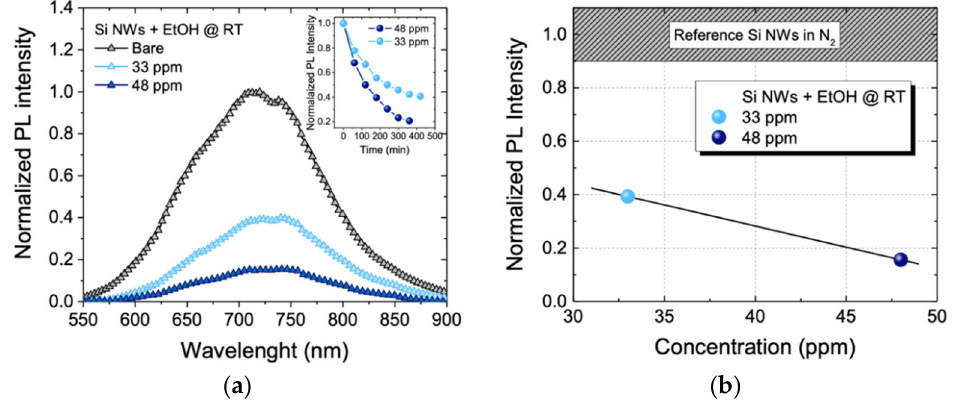
Figure 4. ( a ) Normalized luminescence spectra at RT of the sensor exposed to 350 cc/min of N 2 (black line), 33 ppm of EtOH (cyan line), 48 ppm EtOH (blue line) and 180 ppm NO2 (blue line). ( b ) Sensor calibration curve at RT.